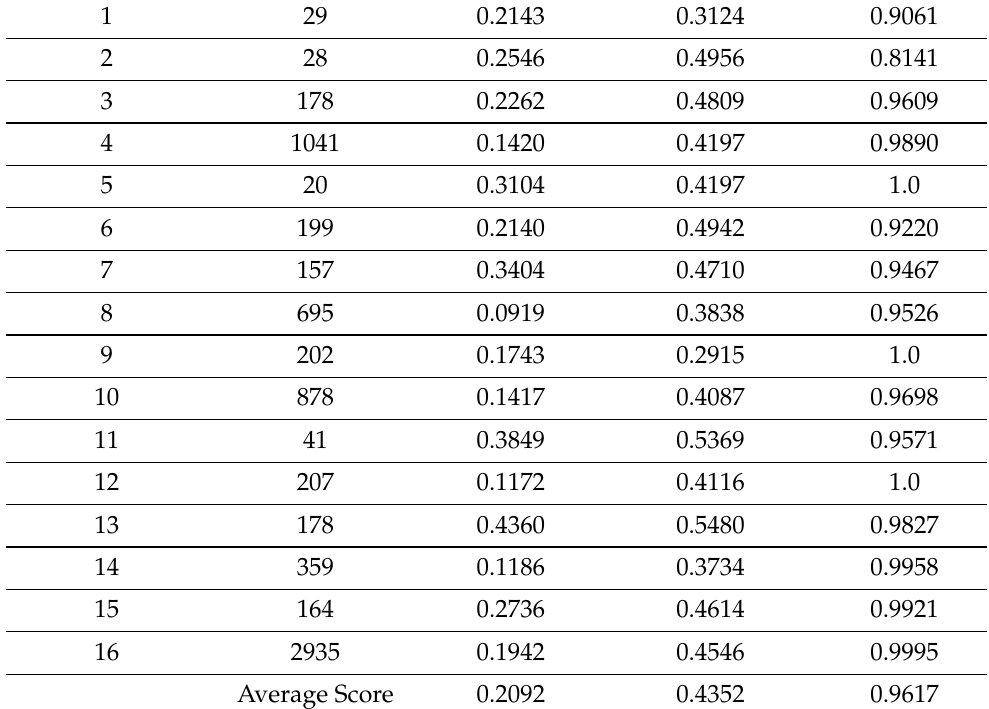
Table 10. Results of Sentiment Analysis